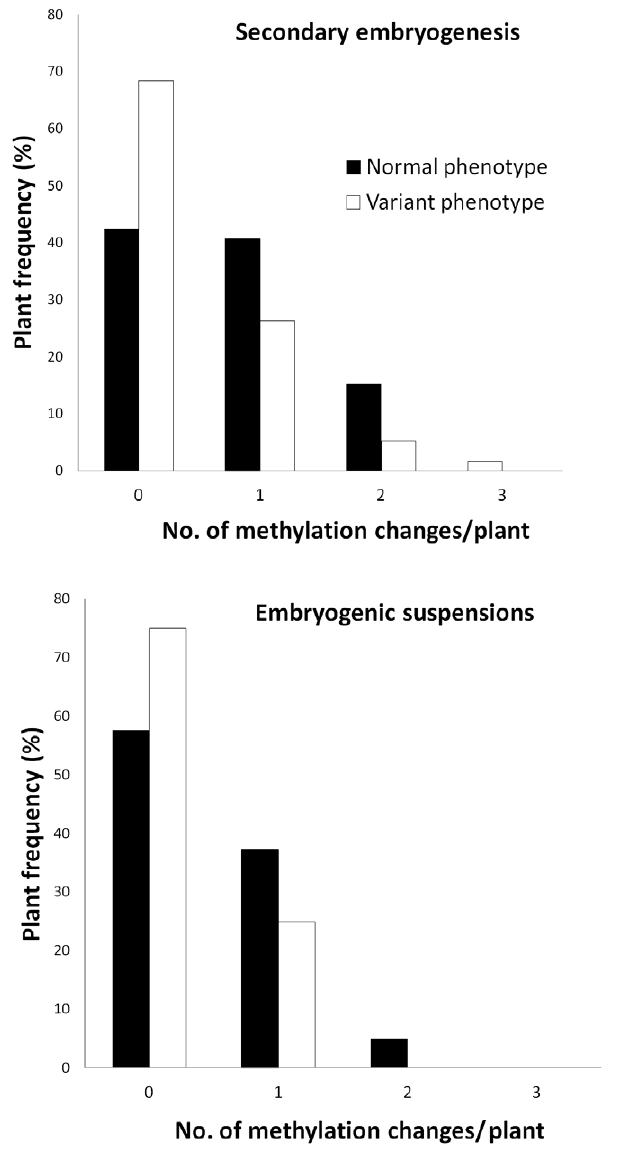
Figure 5. Methylation polymorphism accumulation in coffee emblings showing a normal vs . variant phenotype depending on the somatic embryogenesis process used. For the secondary embryogenesis process, data were derived from the analysis of 59 phenotypically normal and 19 variant emblings. For the embryogenic suspension process, 59 phenotypically normal and 8 variant emblings were studied.